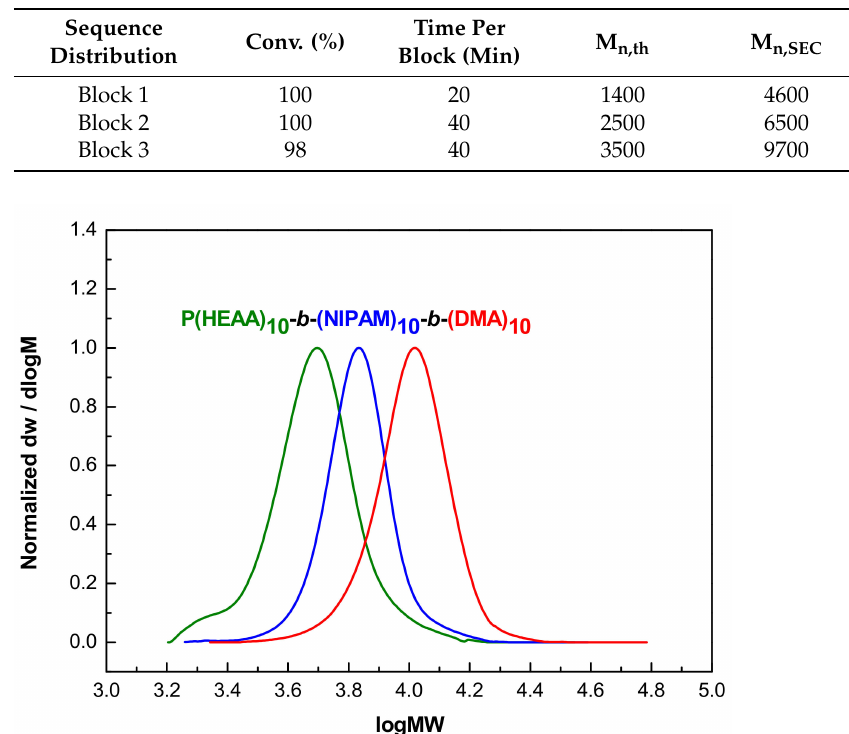
Figure 1. The evolution of molecular weights of successive block extensions of HEAA, NIPAM and DMA by iterative Cu(0)-mediated